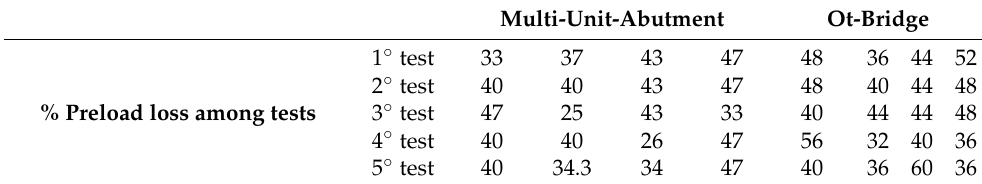
Table 1. Results, % preload loss during 5 tests.